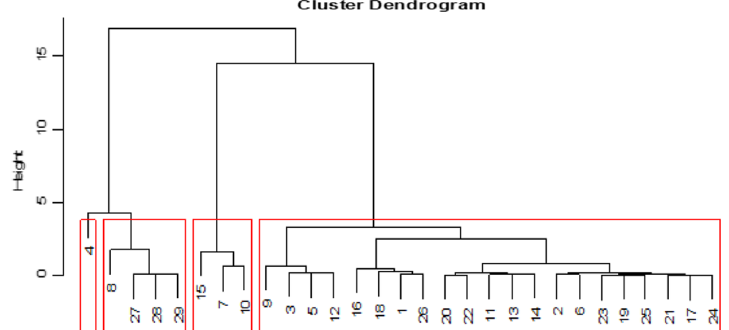
Fig. 15 Cluster dendrogram with spatial correlations in Stage 2. Note The numbers 1, 3, 12, 14, 16, and 23, 26 denote stock indices in developed markets; the remaining numbers denote indices in developing markets, according to Tables 2 and